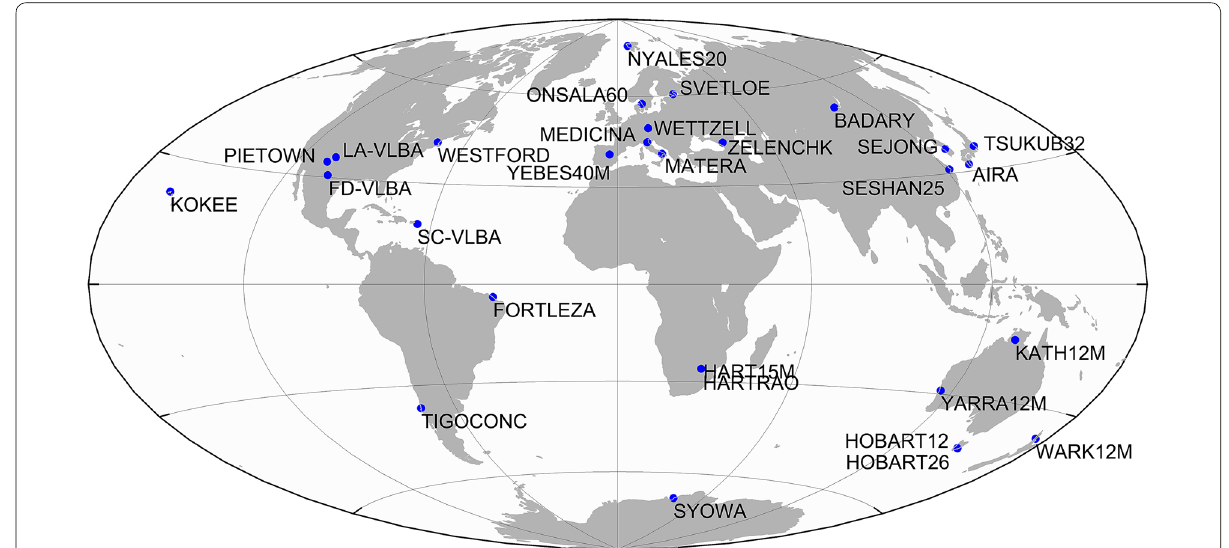
Fig. 2 Location of the VLBI stations analyzed in the position domain